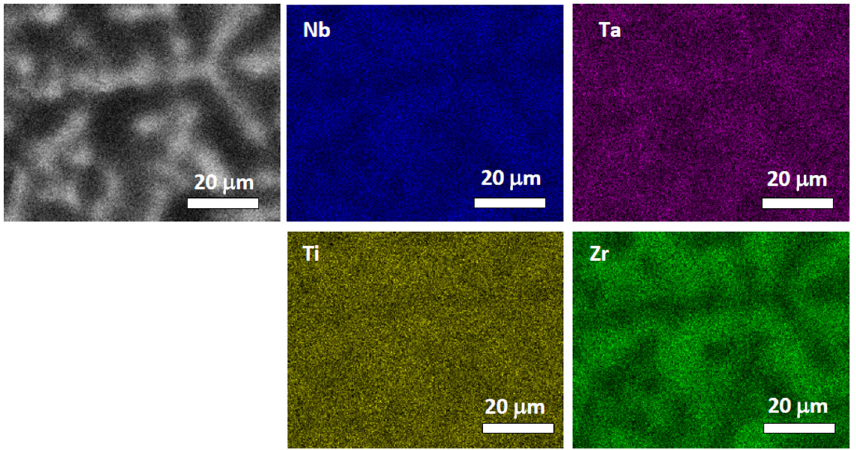
Figure 5. EDS elemental maps of NbTaTiZr alloy annealed at 1200 °C (SEM micrograph in the upper left panel shows the inspected region).